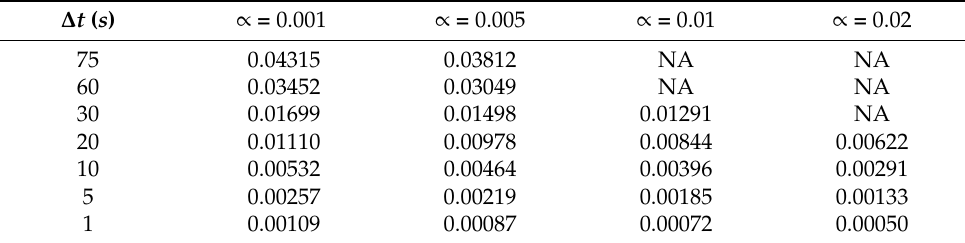
Table 5. L ∞ norm errors of the ERK4-NCCD scheme for different time steps ∆ t and ∝ values at t = 3000 s. NA indicates that the solution did not